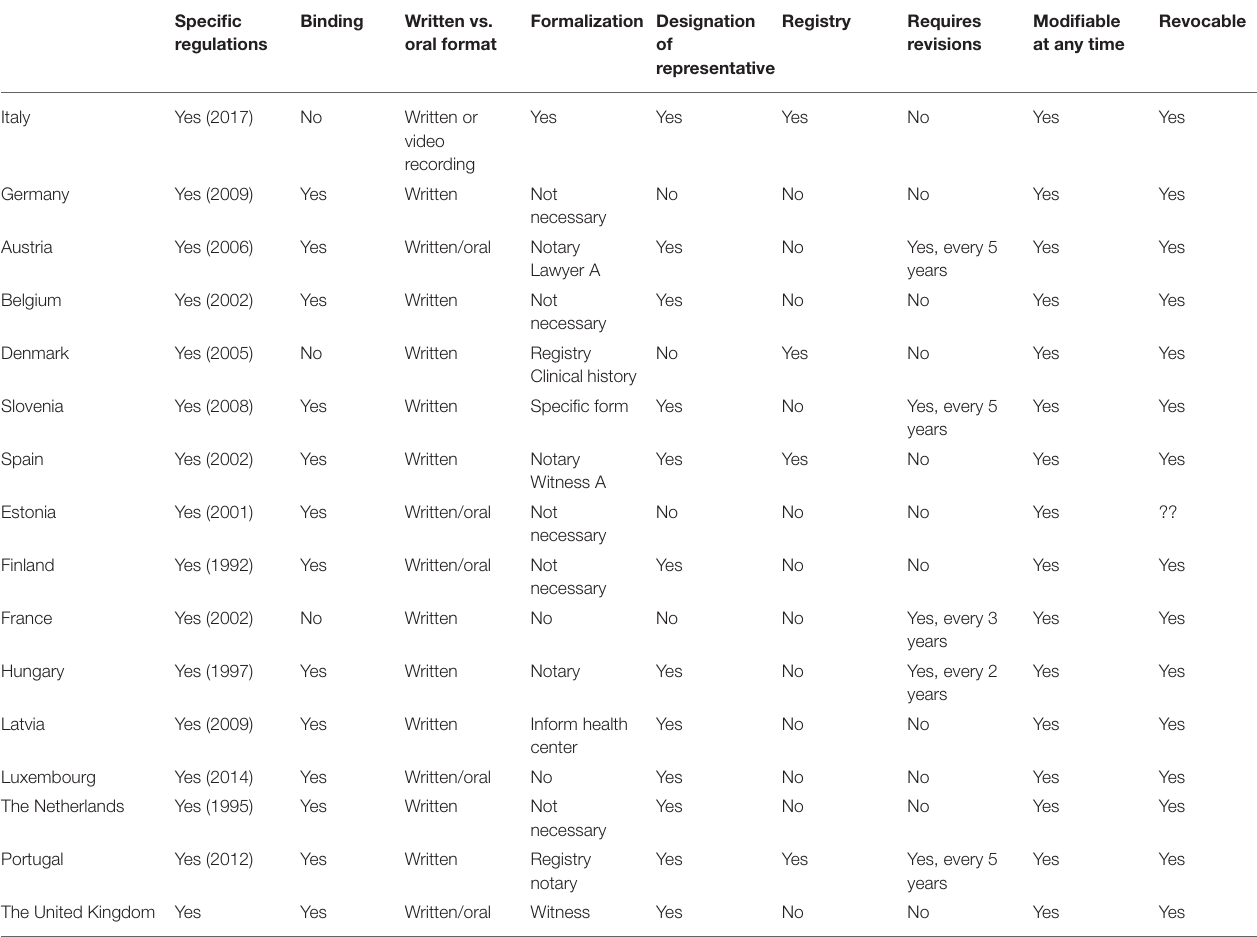
TABLE 2 | Characteristics of European Union countries legal system in the field of living